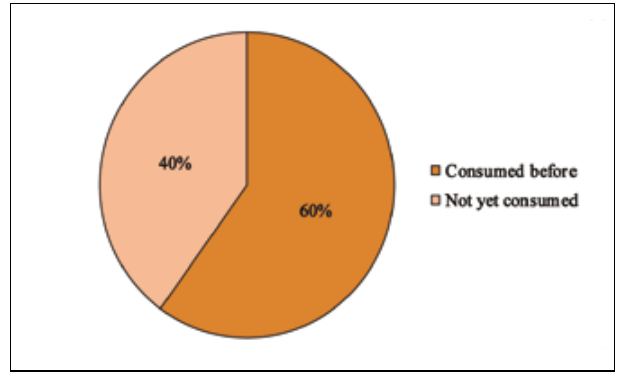
Figure 5. Asparagus consumption by young generation (under 30 years)